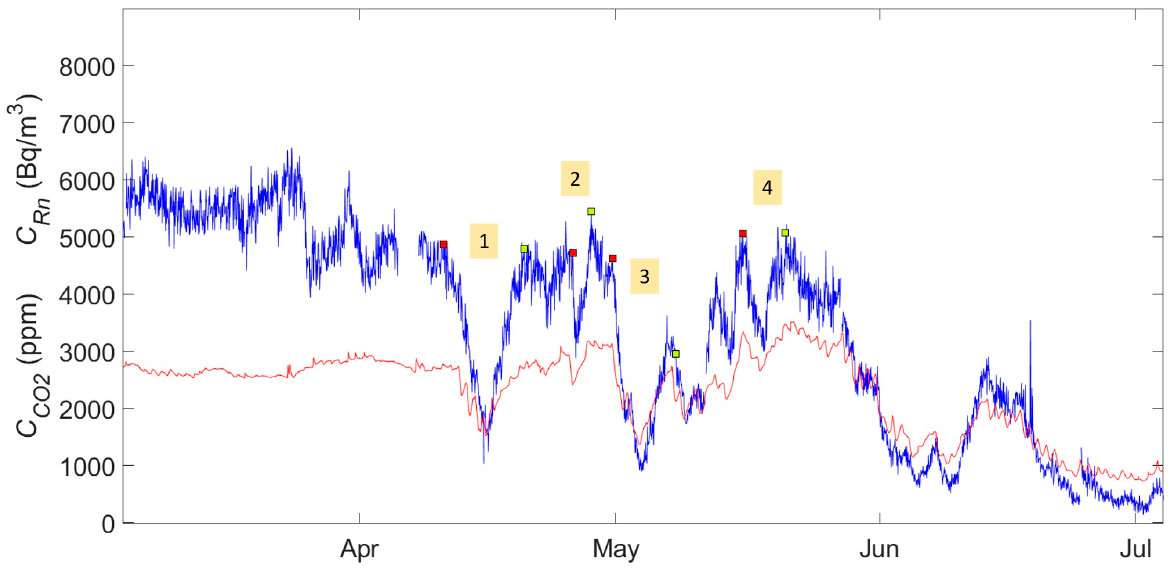
Figure 4. Degassing and recharging events identified in the first half of 2015 labeled with number 1, 2, 3 and 4 for radon (blue) and CO 2 (red). Red markers show the start of the degassing, and the green ones show the end of recharge.